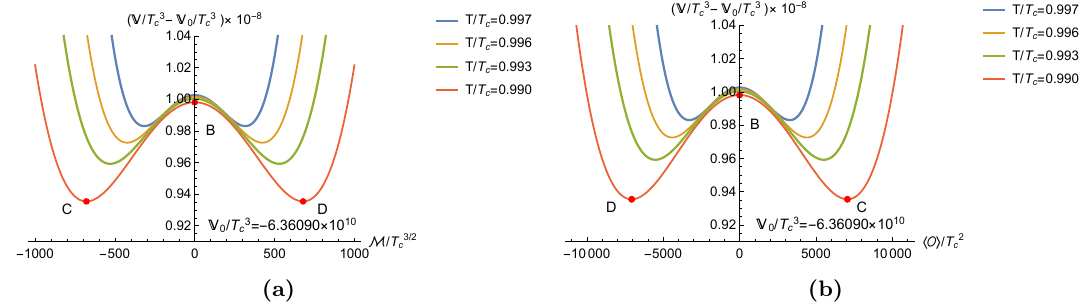
Figure 6 . The e(cid:11)ective potential in terms of (a) the magnetization, (b) the condensation. The point B, C and D correspond to the same points in (cid:12)gure 1a and